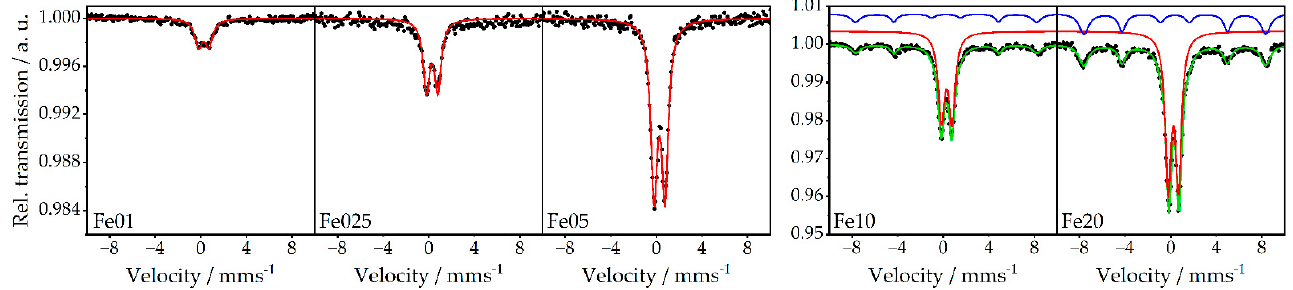
Figure 6. Room-temperature 57 Fe Mössbauer spectra of Fe01 to Fe20 (black dots) with the respective fits; red: doublet; blue: sextet; green: cumulative fit. Table 3. Parameters obtained from room-temperature 57 Fe Mössbauer spectra of Fe01 to Fe20. δ =